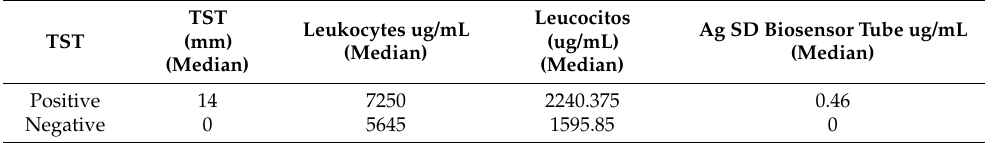
Table 5. Evaluation of gamma interferon levels stimulated by antigens using the novel IGRA tech- nique in patients being studied in the infectious disease department with the TST technique (positive and negative